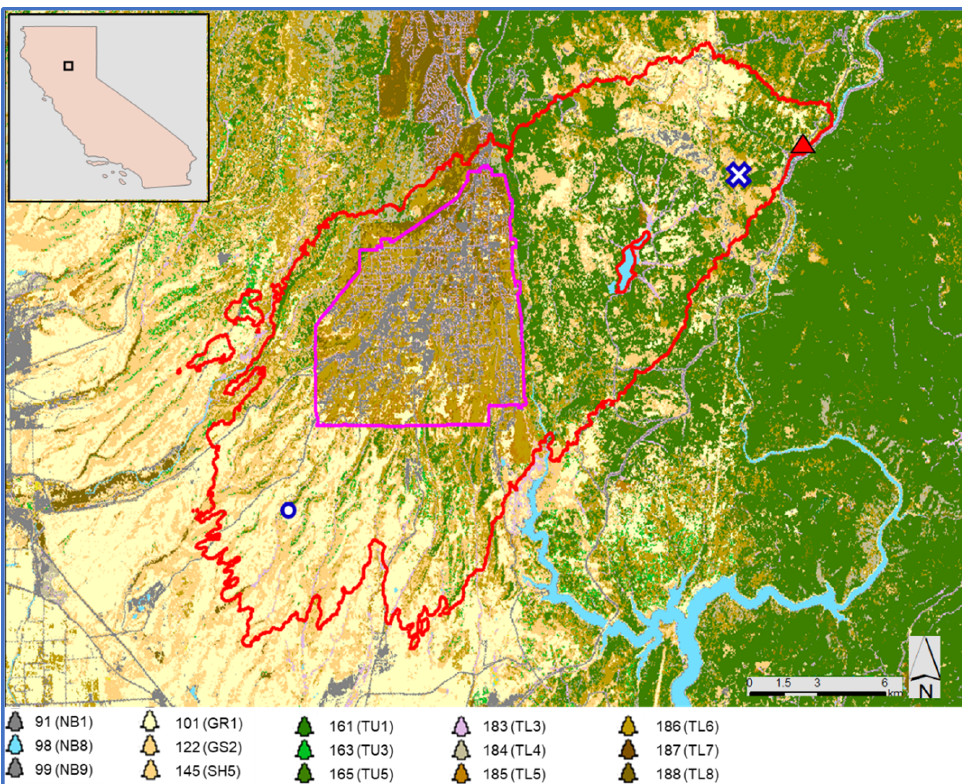
Figure 1. Map of Scott and Burgan Fire Behavior Fuel Models [30] in the 2018 Camp Fire domain. Inset shows the domain location in California, USA. Observed burn perimeter at 18:00 PST on Nov. 8th is shown in red contour and Paradise Township boundary is shown in magenta contour. Yellow color indicates grass (GR) fuels, light orange color shrub (SH) or grass-shrub mix (GS) fuels, green color timber understory (TU) fuels, and brown color timber litter (TL) fuels in the Scott and Burgan fuel models. Bodies of water are shown in blue. The upwind (downwind) weather stream location is shown with blue cross (circle) marker. The location of the ignition is indicated with a red triangle.